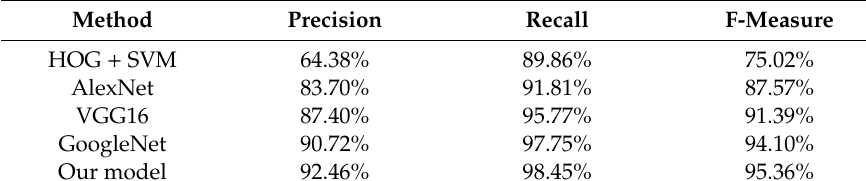
Table 4. Comparison of related numerical indicators for different methods.